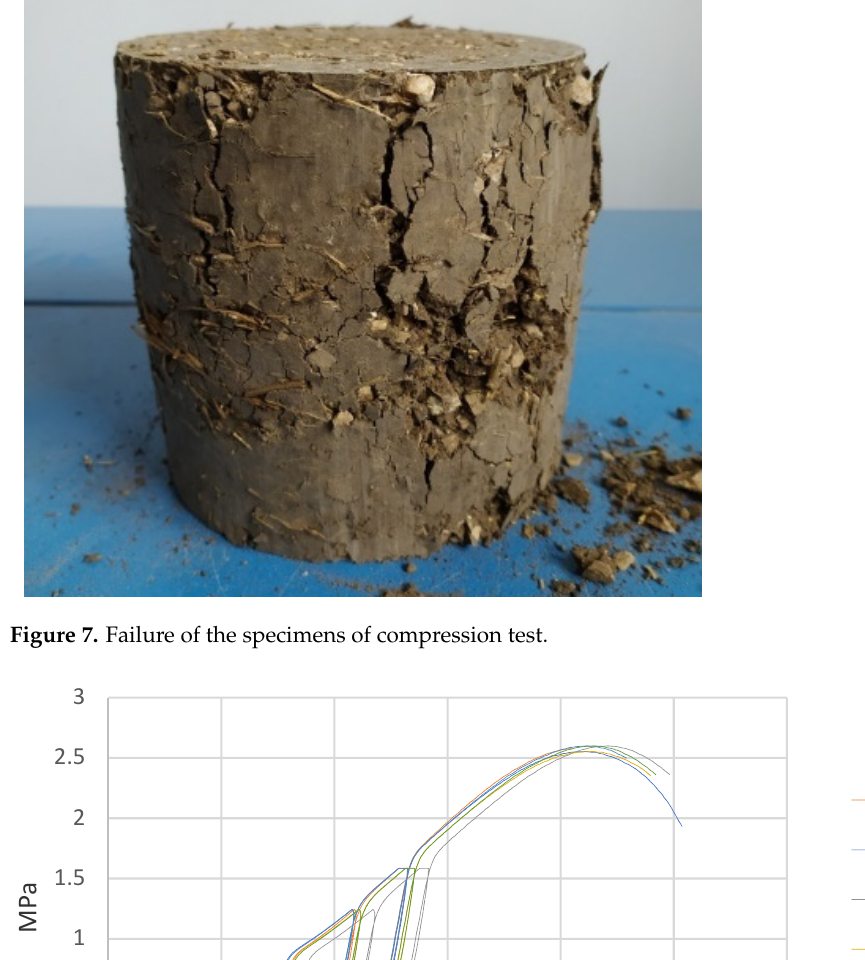
Figure 8. Stress–deformation plot relating to S3_1–S3_6 cylindrical samples subject to an uncon- fined compression test.